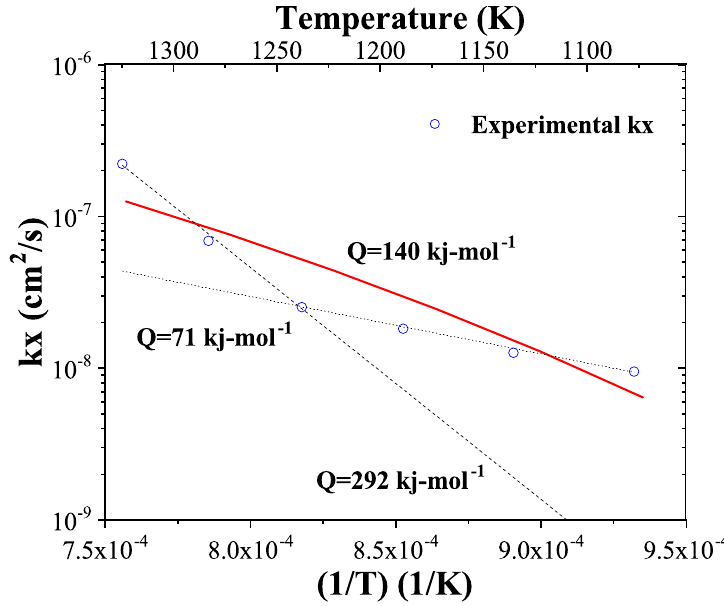
Figure 6. Activation energies by the Arrhenius equation and the kinetic parameters k x at different